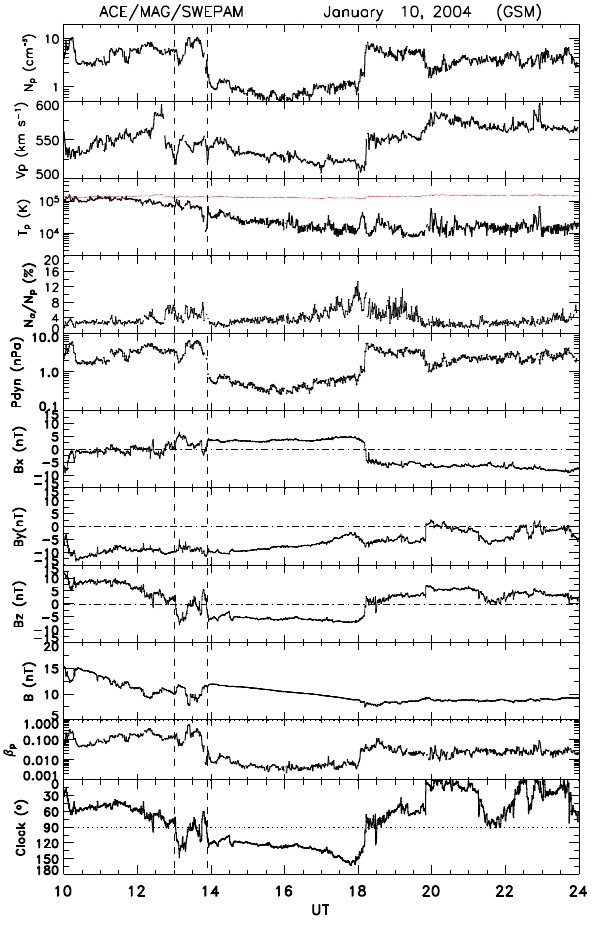
Fig. 2. Interplanetary plasma and field data obtained from space- craft ACE during the interval 10:00–24:00UT on 10 January 2004: proton density, bulk speed, and temperature (in red: expected tem- peratures for normal solar wind expansion after Lopez, 1986), the alpha-particle-to-proton number density ratios, the dynamic pres- sure, the components of the magnetic field in GSM coordinates, and the total field strength, the proton plasma beta and the clock angle of the magnetic field.